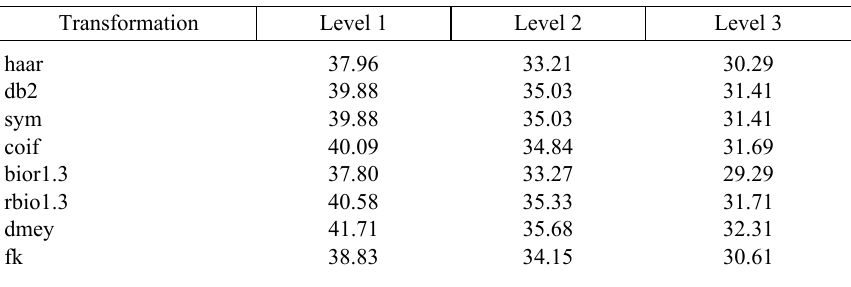
Table 3. PSNR (dB) values for three decomposition levels obtained by applying different wavelet transformations to the original image with MD Transformation Level 1 Level 2 Level 3 haar 26.15